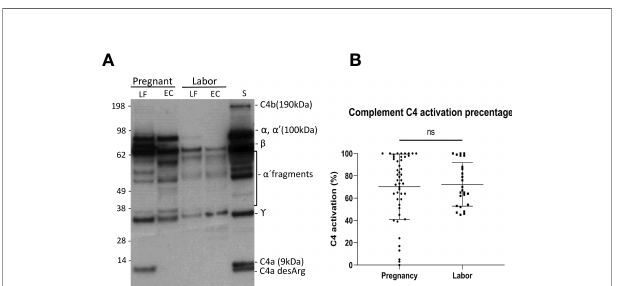
FIGURE 3 | Activation of the alternative pathway in the vaginal mucosa during pregnancy and labor analyzed by detecting cleavage of factor B (A) shows the cleavage of factor B in the vaginal samples and in normal human serum (S) for reference. The cleavage was studied by running the samples in SDS-PAGE under reducing conditions and using Western blotting with a polyclonal goat antihuman factor B antibody. Results from six patients in our study groups are presented. Three samples (1-3) were taken during late pregnancy and three (4-6) during active labor. Two samples per patient are shown: one from the lateral fornix (LF) and the other from external cervix (EC). The 90 kDa factor B is a single-chain molecule that is cleaved by factor D to Ba (~33 kD) and the catalytic subunit Bb (~60 kD). (B) shows the calculated percentages of factor B activation in both groups by calculating the proportions of activation fragments relative to total amount of factor B Stronger activation is noted in samples taken during pregnancy (p>0.001).